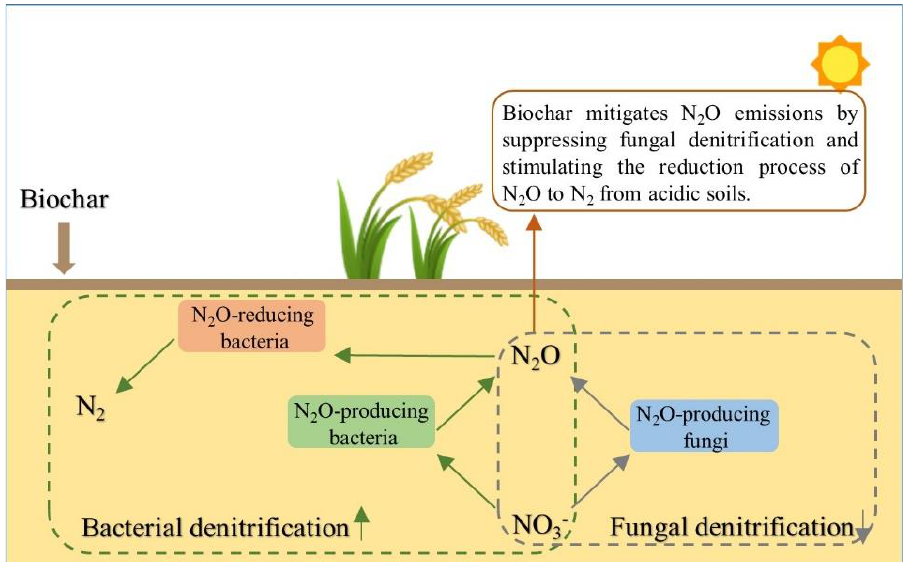
Figure 2. Potential mechanism of N 2 O emission reduction following biochar amendment from acidic soils.